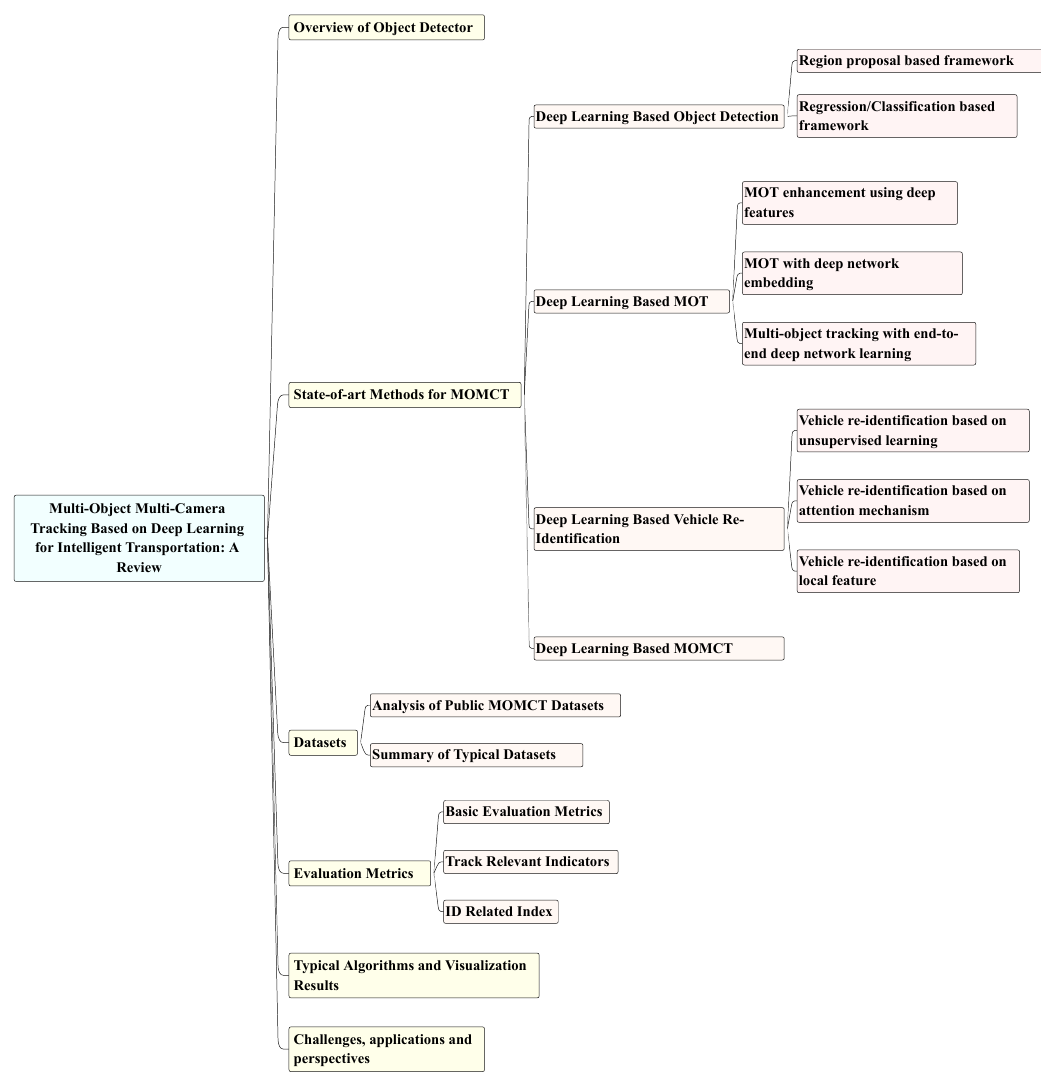
Figure 2. Hierarchical structure of the MOMCT based on deep